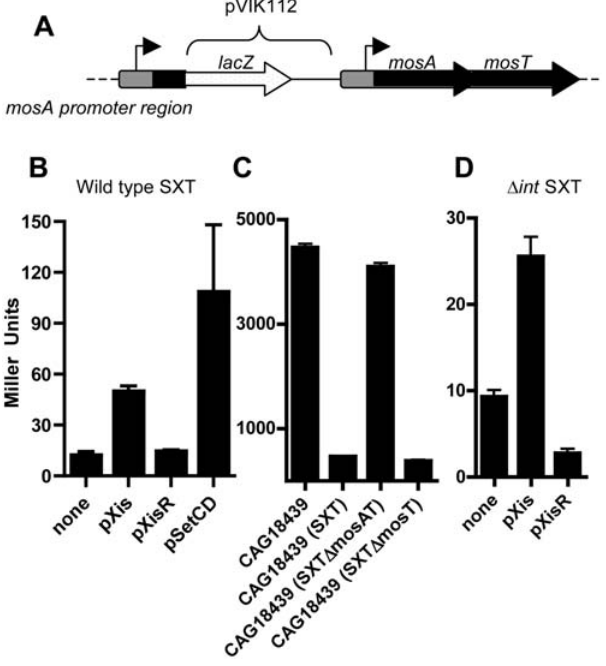
Figure 6. Influence of Xis and SetCD on mosA expression. A) Schematic of chromosomal mosA :: lacZ transcription reporter within the mosAT locus. Thick black arrows represent ORFs as predicted by bioinformatics and the thin arrow represents the predicted location of the mosA promoter. B, D) b -galactosidase activities of the chromosomal mosA::lacZ fusion in CAG18439 containing wt SXT (B) or in CAG18439 containing D int SXT (D) along with the indicating expression vectors. C) b -galactasidase activities from a plasmid-borne mosA-lacZ fusion (in pPmosA) in the indicated strains. All b - galactasidase measurements were conducted on 15 hr cultures and the results shown are the means and standard deviation from at least 9 independent